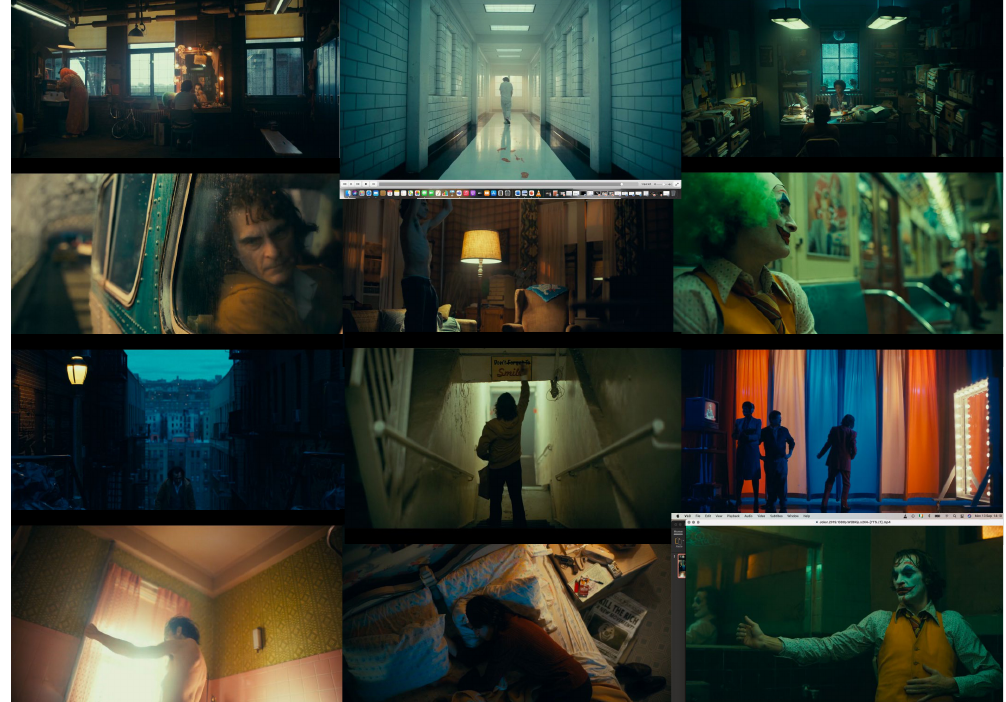
Figure 6 The Language of Phillips’